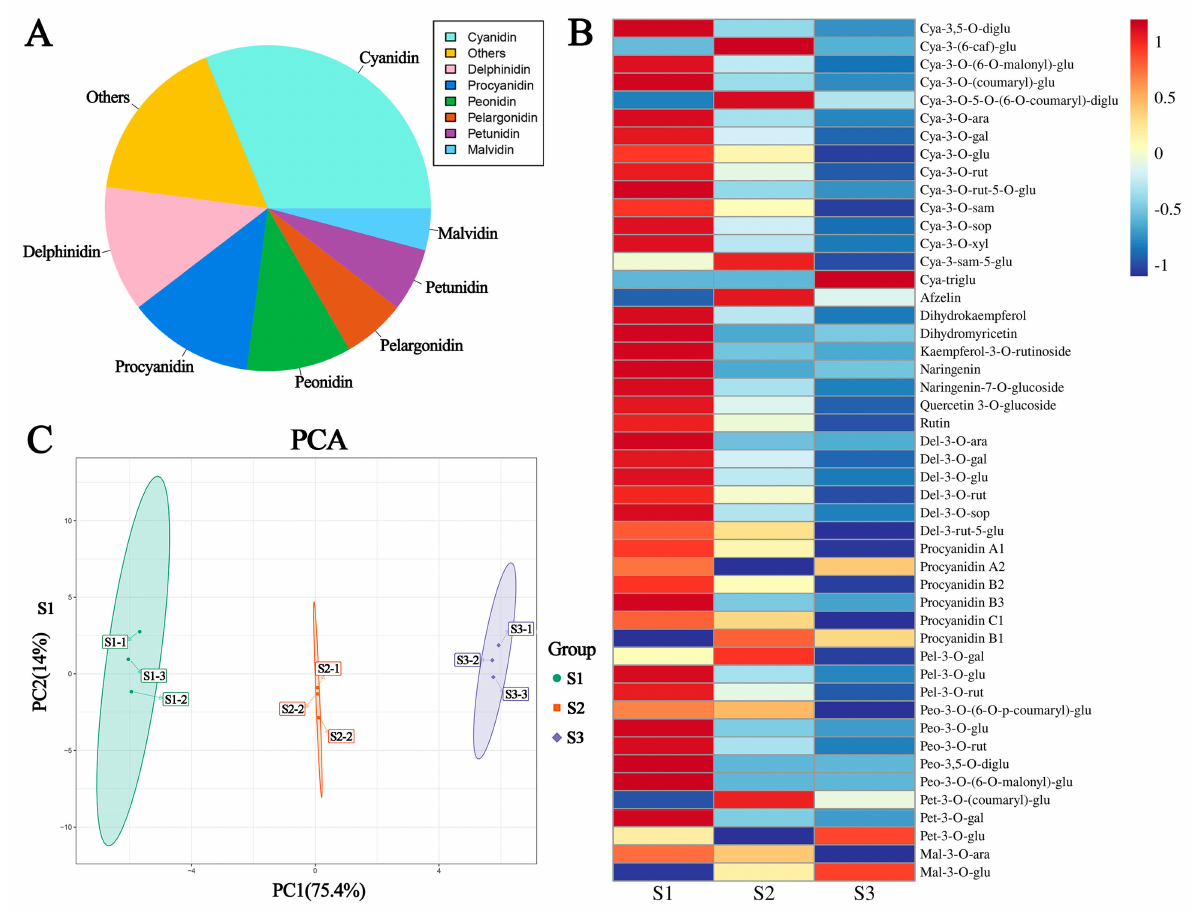
Figure 2. Analysis of anthocyanin levels in three developmental stages of red P. bournei leaves. ( A ) Metabolites detected in leaves at three developmental stages; ( B ) heatmap analysis of all detected metabolites; ( C ) the principal component analysis (PCA) plot illustrates clear discrimination among metabolites in the three developmental